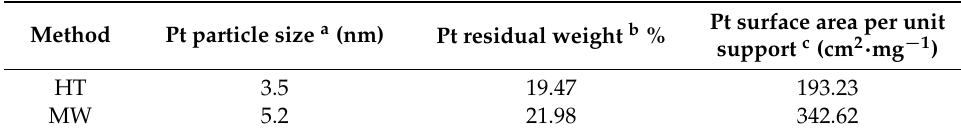
Table 1. Properties of Pt loaded on XC72 with different